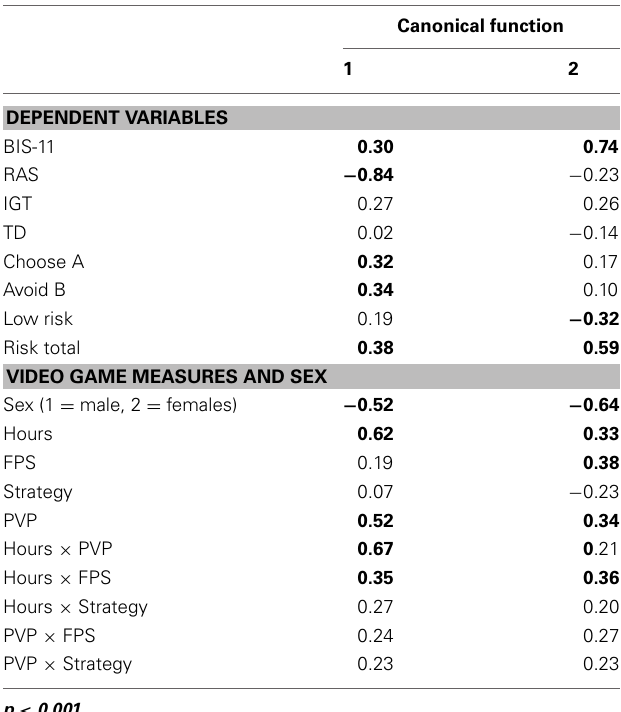
Table 4 | Canonical correlations after varimax rotation of the dependent variables.